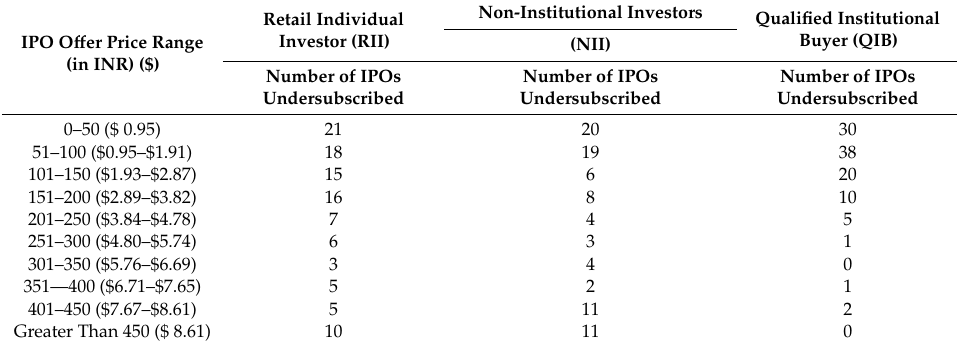
Table 1. IPO o ff er price bands and numbers of IPOs undersubscribed within the qualified institutional buyer (QIB), non-institutional investor (NII), and retail individual investor (RII) categories (2006–2015) (Oversubscription and undersubscription data have been taken from http: // www.chittorgarh.com / and NSE India for each category). The UDS $ conversation rate is the average rate (INR-$) between 2006–2015. (Source—RBI